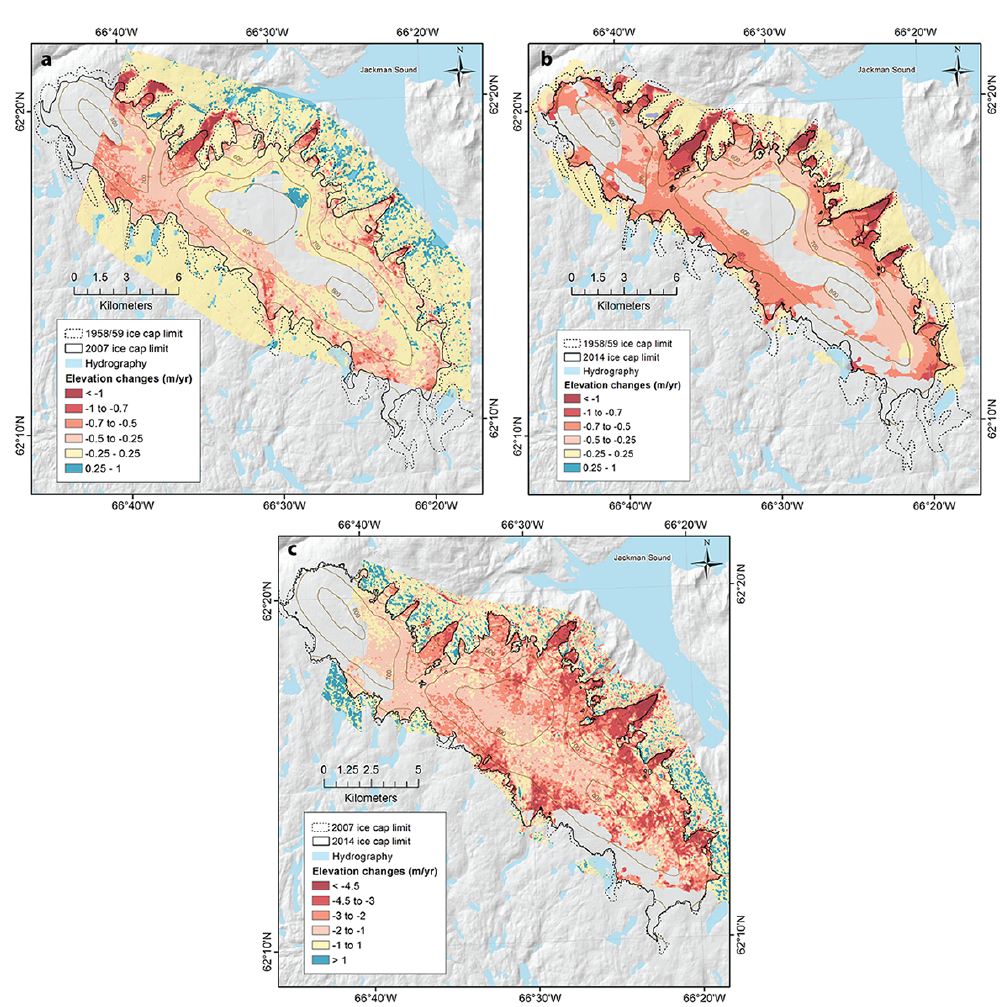
Figure 5. (a) Elevation change rates (d H /d t , ma − 1 ) on Terra Nivea Ice Cap (TNIC) between 1958/59 (CDED) and 2007 (ASTER DEM). (b) d H /d t on TNIC between 1958/59 (CDED) and 2014 (Pléiades DEM). (c) d H /d t on TNIC between 2007 (ASTER DEM) and 2014 (Pléiades DEM). Note a different color scale for the lower panel (c) .